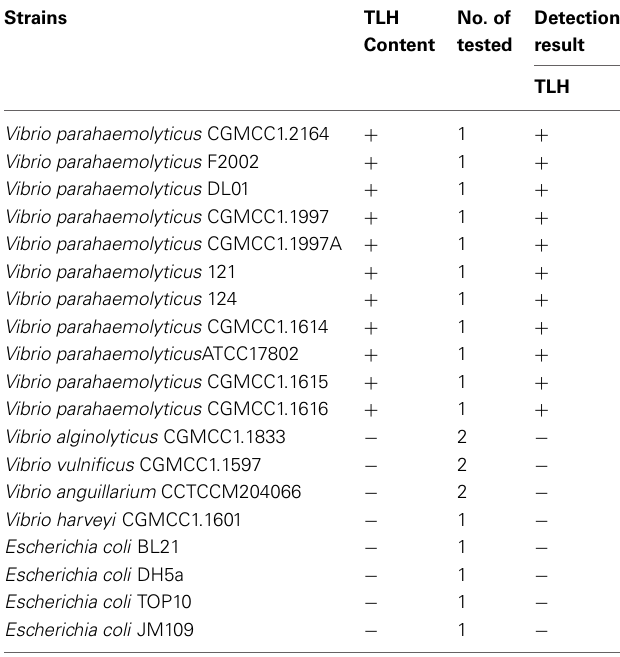
Table 2 | Detection of bacterial samples ∗ . Strains TLH No. of Detection Content tested result